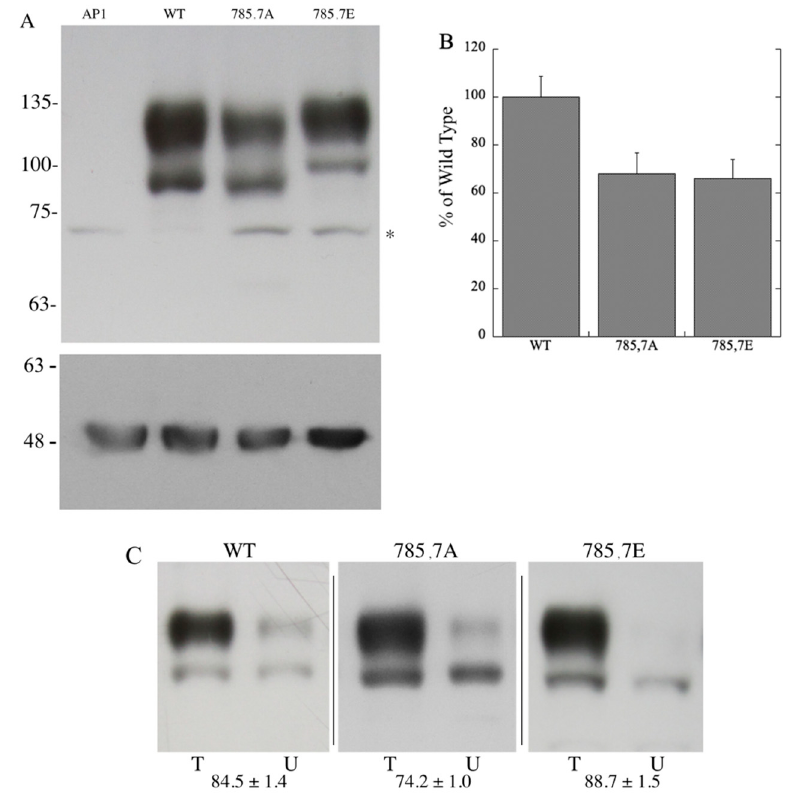
Figure 1. Expression and targeting of wild-type NHE1 and mutant NHE1 proteins. ( A ) Upper panel, Western blot of whole-cell lysates of stably transfected AP1 cells containing the wild-type (WT) or indicated NHE1 proteins. Asterisk indicates non-specific immunoreactive band present in all cell lysates. WT, wild type. AP1, mock transfected AP1 cells. Lower panel, blot re-probed with anti- tubulin antibodies. ( B ) Bar graph illustrating relative expression levels of WT, 785A, 787A mutant cells and 785E, 797E containing cells. Results are the mean ± S.E. of at least four experiments. ( C ) Cell surface localization of wild-type and mutant Na + /H + exchanger proteins expressed in AP-1 cells. Equal amounts of total cell lysate (T, left lane) and unbound intracellular lysate (U, right lane) were examined by Western blotting with anti-HA antibody. The percent of the total NHE1 protein found on the plasma membrane is indicated for each cell type and are the mean ± S.E. n ≥ 3 determinations. Samples for each type of protein are from different Western blots (indicated by dividing line).